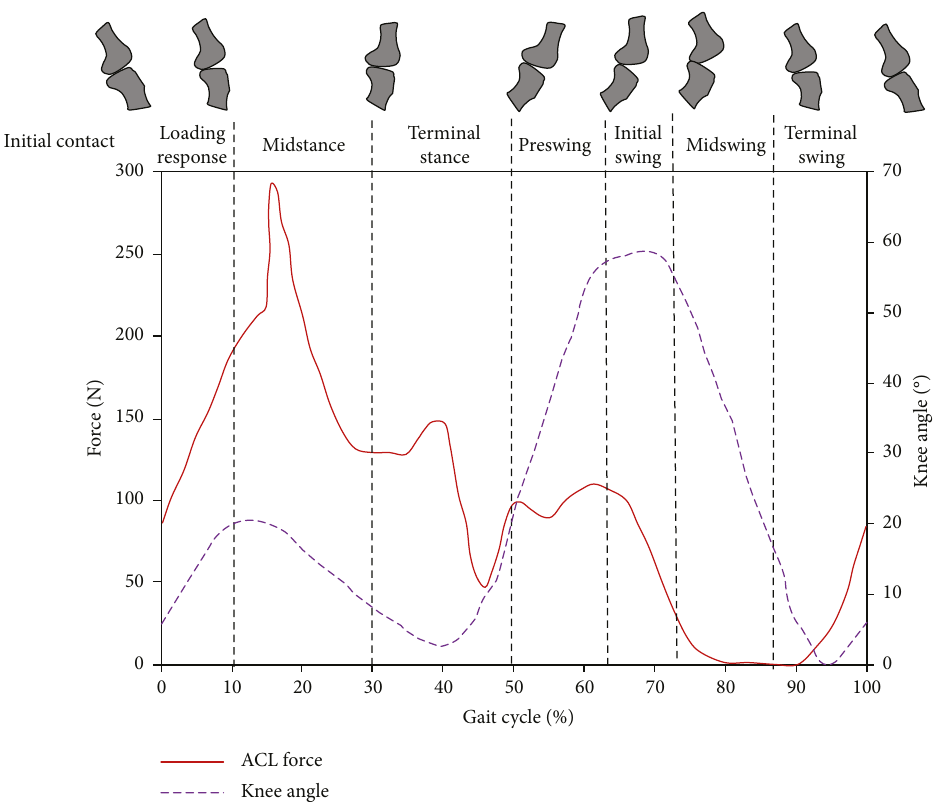
Figure 9: Forces acting on ACL during a simulated gait cycle along with changes in the knee angle during the gait cycle [41,